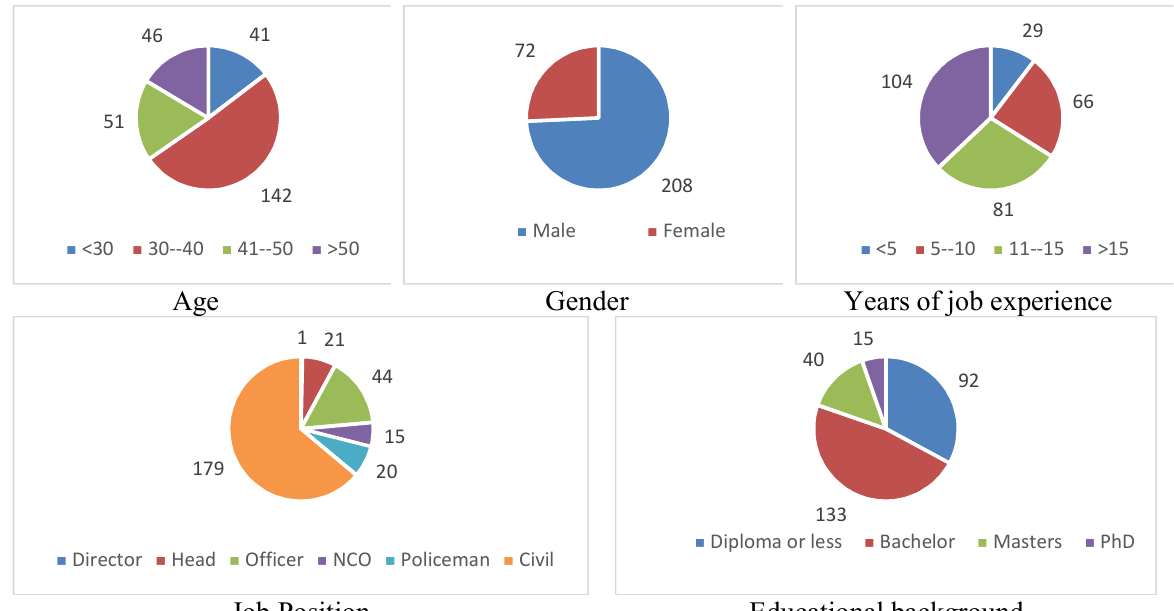
Fig. 2. Demographic profile of survey respondents